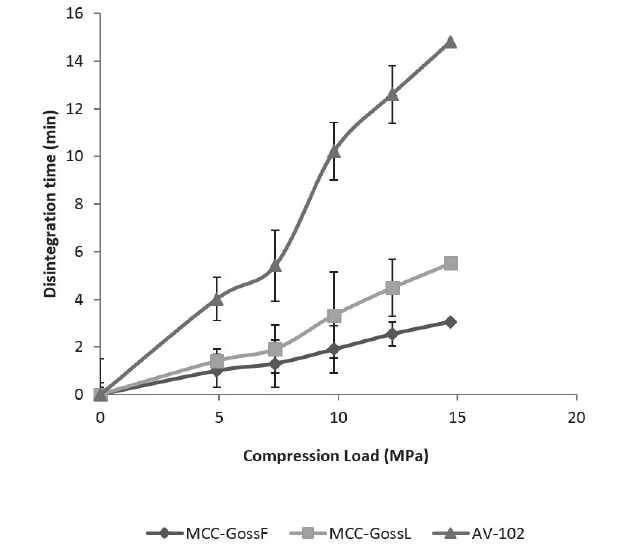
FIGURE 5 - Disintegration plots of MCC-GossF, MCC-GossL and AV-102 .